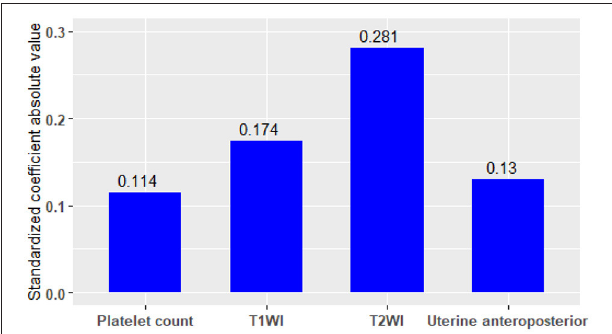
FIGURE 2 | Comparison of the degree among the factors influencing ablative